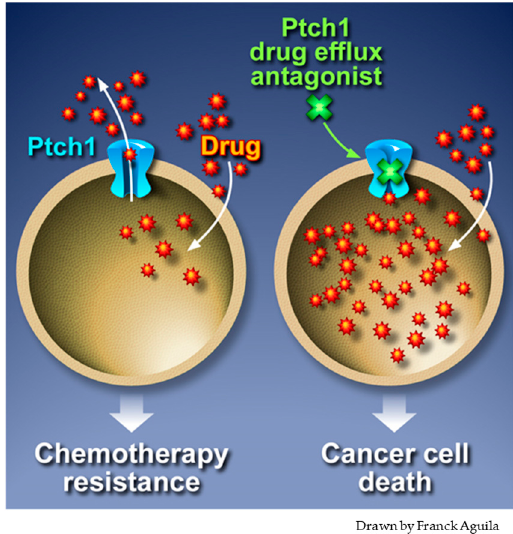
Figure 4. Combination of Ptch1 drug efflux inhibitor and chemotherapy is a potential new therapeutic option to overcome the drug resistance of cancer cells. Ptch1 inhibitor (in green) inhibits the doxorubicin (in red) efflux activity of Ptch1 (in blue). This allows the concentrations of doxorubicin to be reached that are required to kill cancer cells and fight chemotherapy resistance.